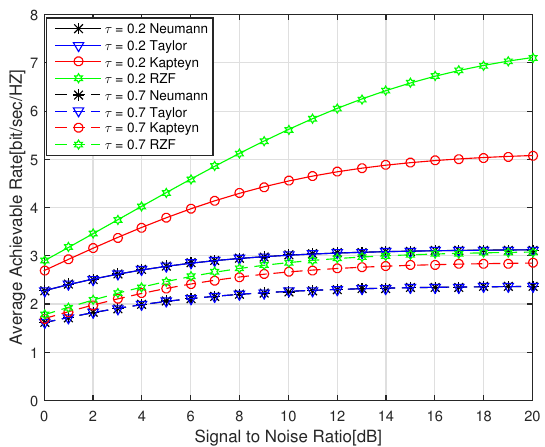
Figure 2. Average achievable rate vs. signal-to-interference-noise ratio (SINR) ( M = 256, K = 32, N = 1).